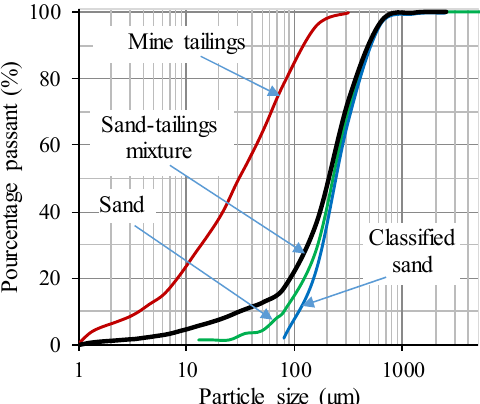
Figure 2. Particle size distribution of the sand-tailings mixture used to produce cemented hydraulic fill (CHF).